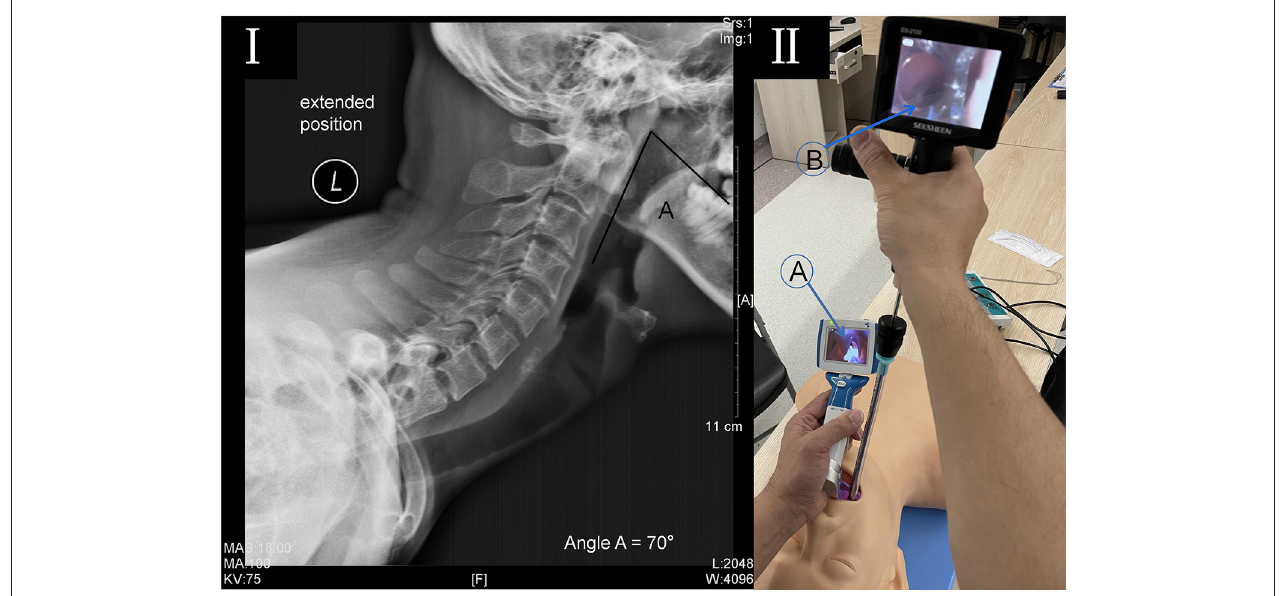
FIGURE 2 | (I) Lateral radiograph of the cervical spine in full extension. The photograph demonstrates that hyperostosis was seen at the cervical vertebral body margin, and the oropharyngeal axis (angle a) was 70 ◦ . (II) A double visualized intubation on a mannequin. (A) The video laryngoscope opens the oropharynx to show the epiglottis; (B) The lighted stylet uncovers the epiglottis to expose the glottis and guide the tracheal tube into the trachea.